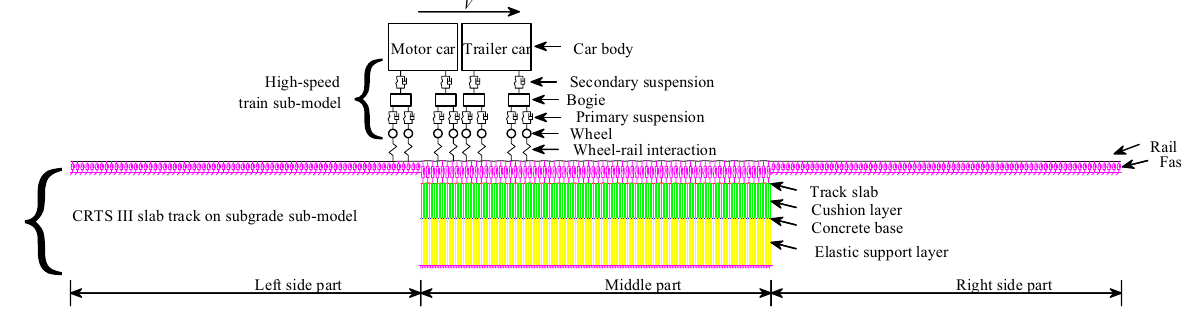
Figure 2. The schematic of the coupled dynamic model.